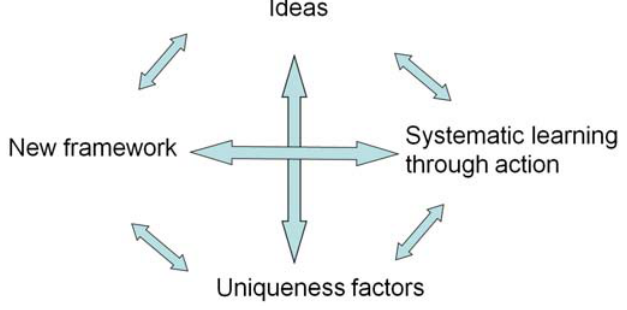
Fig. 1. Framework for the Columbus